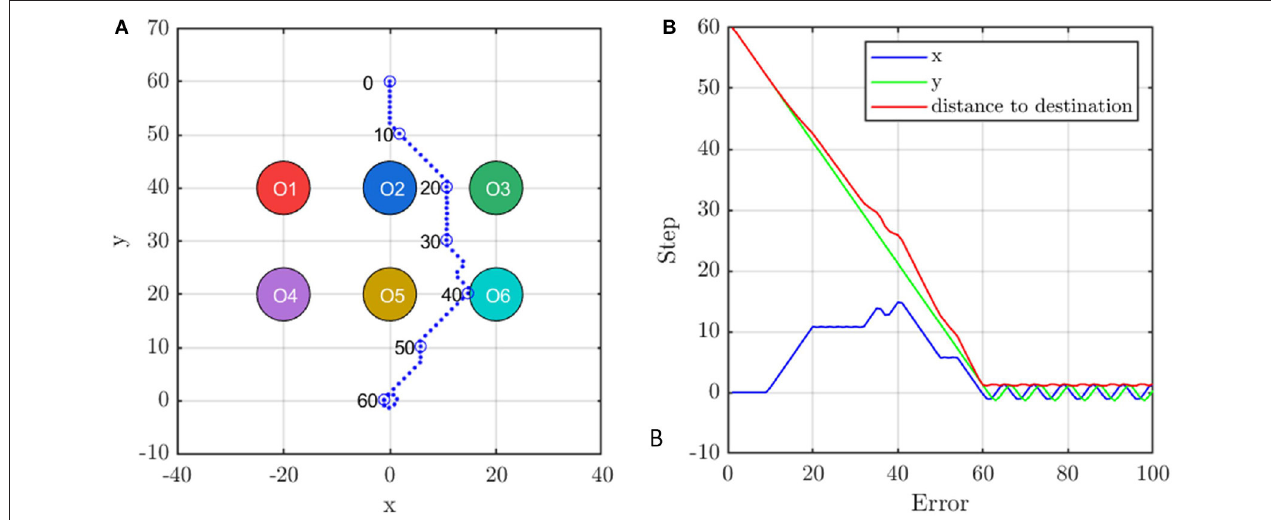
FIGURE 11 | The agent’s (A) trajectory and (B) the distance to the destination during avoiding obstacles. The six colored circles are the collision zone of obstacles and the blue dots are the trace of the agent.